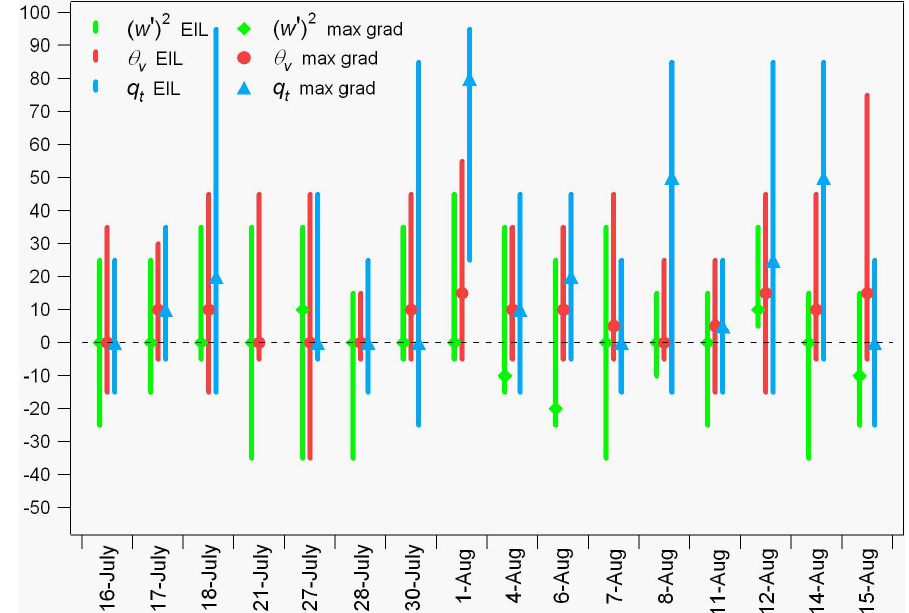
Fig. 6. EIL as defined by three different variables as a function of shifted altitude. The symbol shows the altitude of the maximum gradient in that quantity, and the bars represent the extent of the EIL estimated using the three different variables. All data is averaged over the entire day. For 21 July, no q t EIL could be identified because q t was constant throughout the entire vertical profile ( ± 100 m) of the cloud top